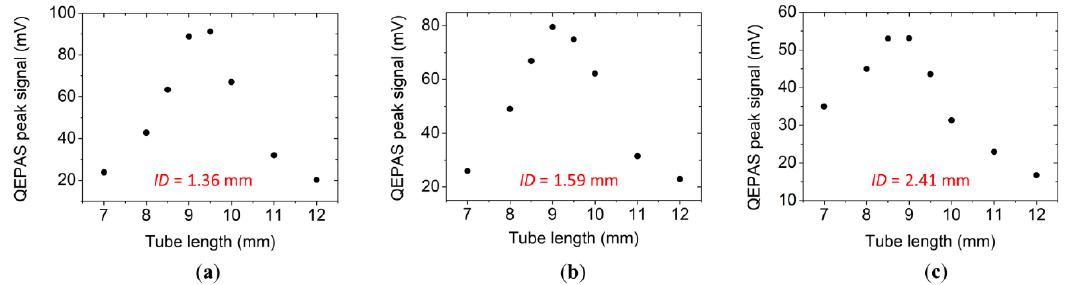
Figure 2. QEPAS peak signals measured with three different spectrophones employing acoustic resonator tubes with an ID = 1.41 mm ( a ), 1.59 mm ( b ), and 2.06 mm ( c ) as a function of the tube length. A l exp of 9.5 mm was measured for ID = 1.36 mm and ID = 1.41 mm, while a l exp = 9.00 mm